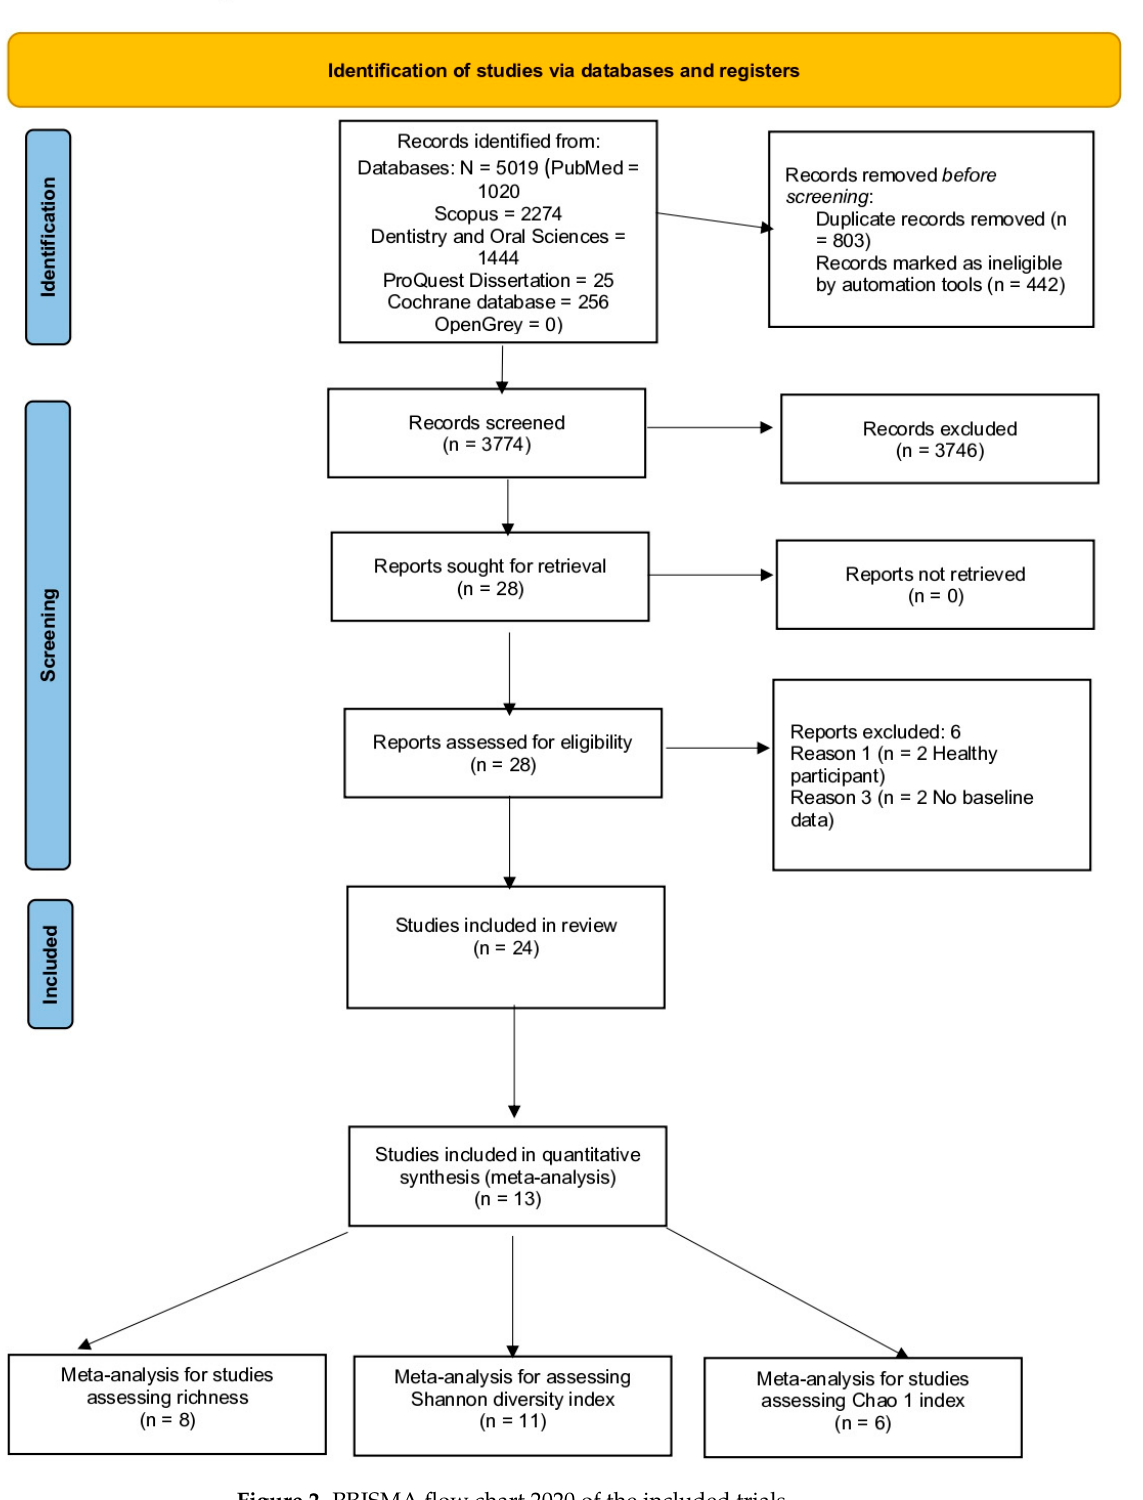
Figure 2. PRISMA flow chart 2020 of the included trials.